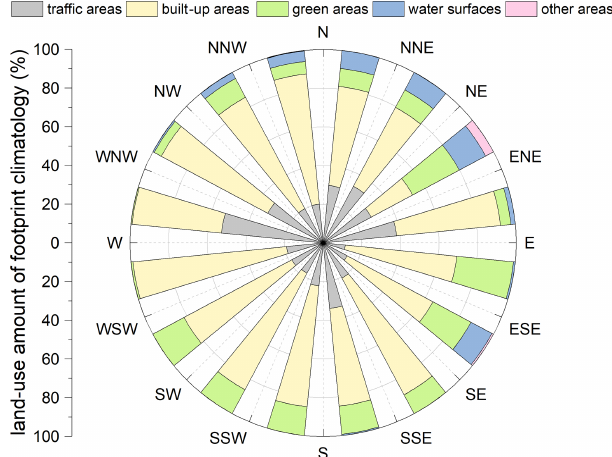
Figure 13. Fraction of land use per wind direction sector contribut- ing to the 3-year flux footprint. For data analysis the flux footprint was defined as a circle centred on the flux site with a radius of